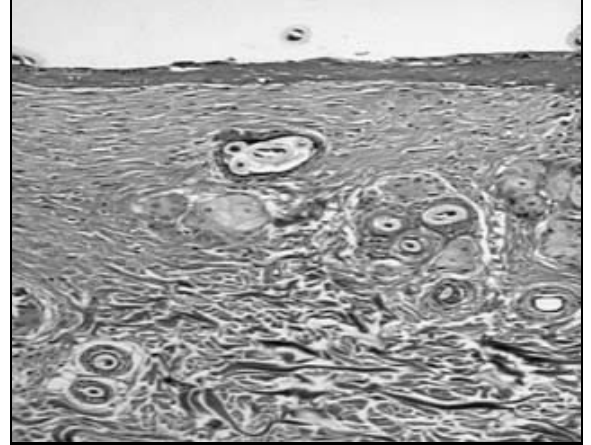
Figura 3 – Corte corado em tricrômico de Mallory de rato do grupo EI, objetiva de 10x, onde se observa fibroplasia com 14 dias, localizada nas dermes superficial e profunda, com atrofia de